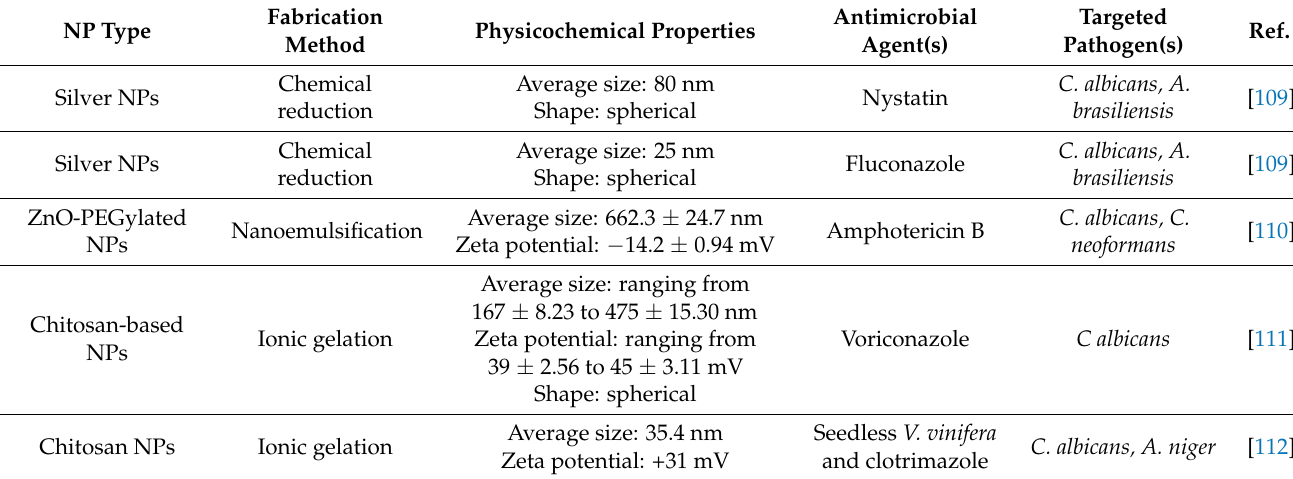
Table 3. Examples of antifungal